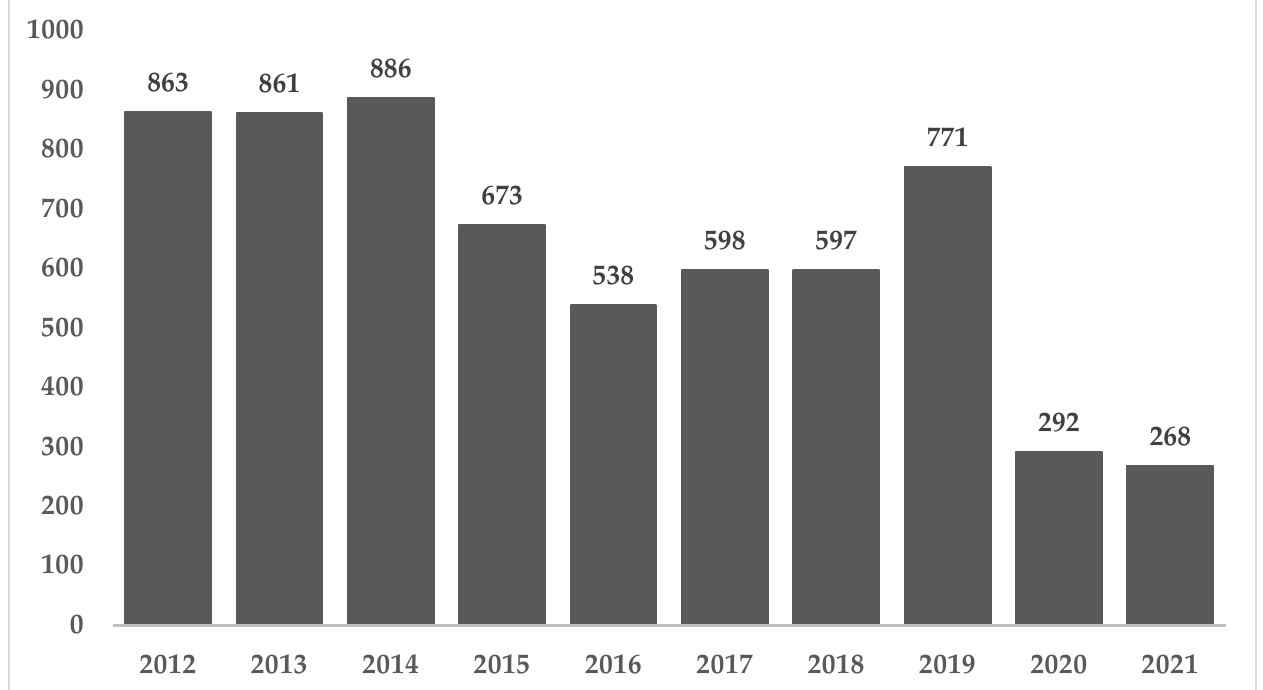
Figure 1. Numbers of FBD outbreaks in Brazil between 2012 and 2021. Adapted from [8].